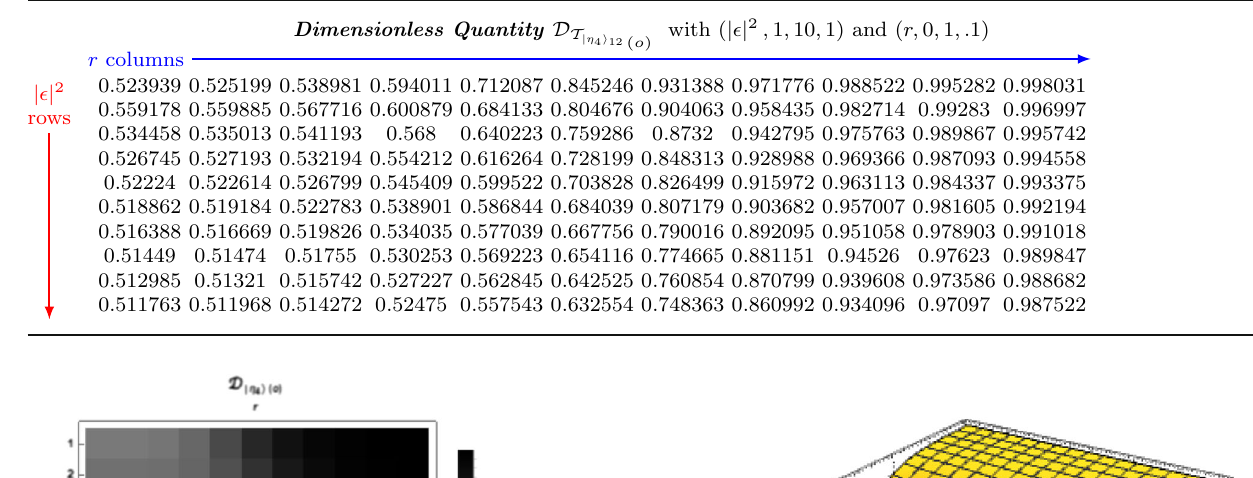
Table 13 Numerical values of D T for some range and choices of coherent and squeezing parameters. Here, | (cid:11) | 2 takes on value from 1 to 10 and r varies from 0 to 1